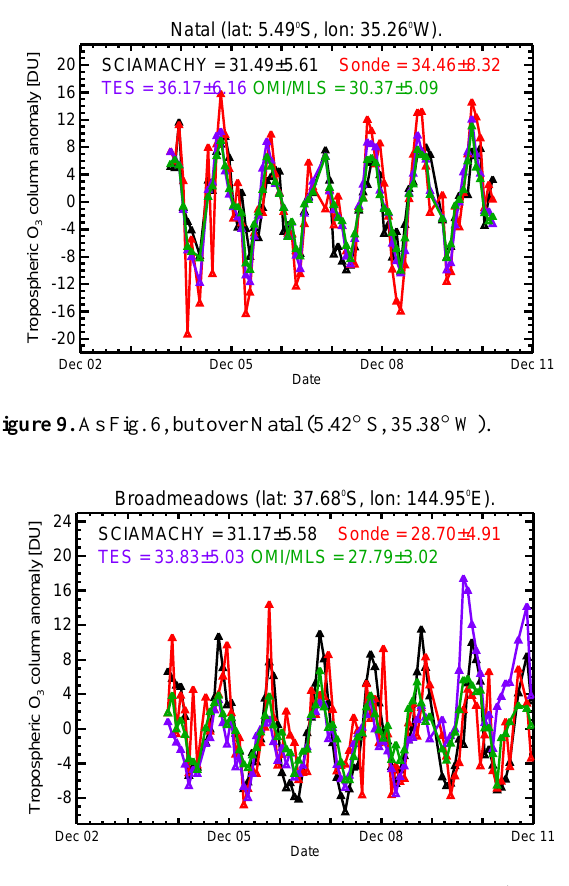
Figure 10. As Fig. 6, but over Broadmeadows (37.68 ◦ S, 144.95 ◦ E).